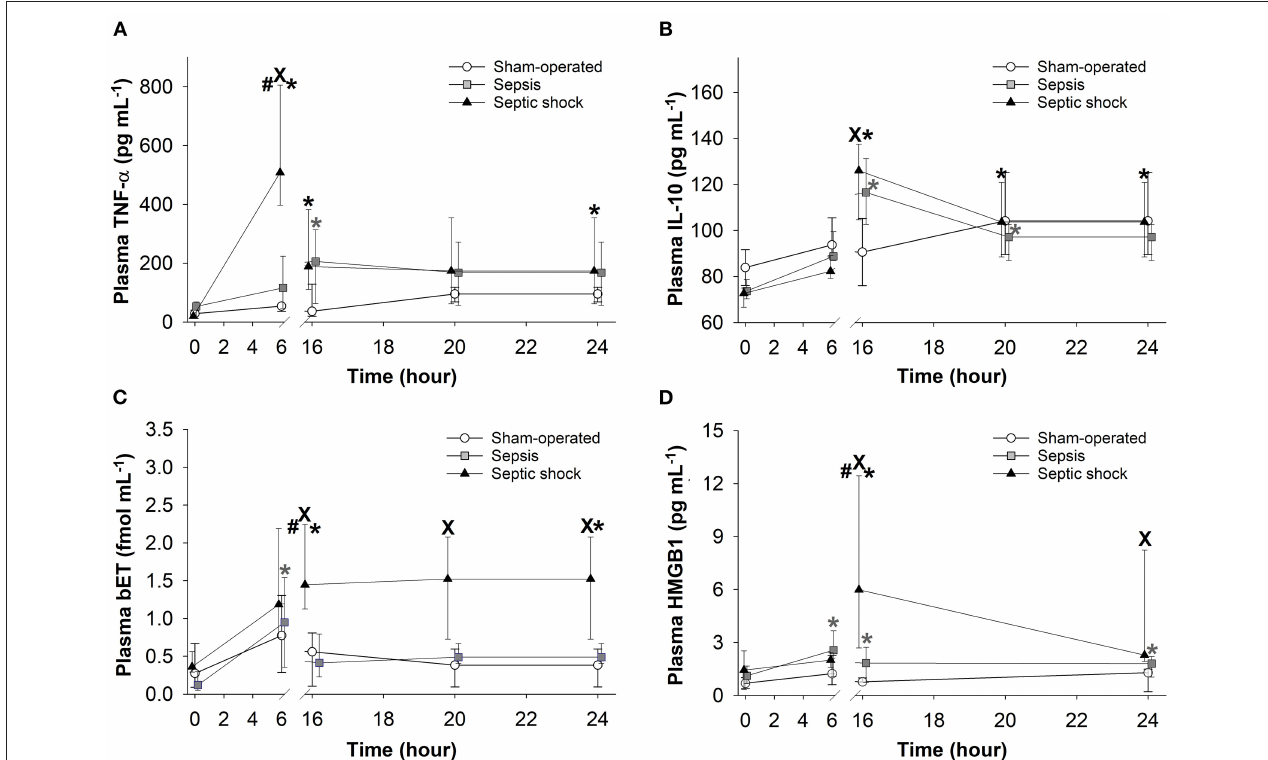
FIGURE 8 | Changes in plasma tumor necrosis factor alpha (TNF- α ) (A) , interleukin-10 (IL-10) (B) , big endothelin (bET) (C) , and high-mobility group box 1 protein (HMGB1) (D) levels in the sham-operated group (open circles) and in the sepsis (gray square) and septic shock subgroups (black triangle). The plots demonstrate the median values and the 25th (lower whisker) and 75th (upper whisker) percentiles. X P < 0.05 vs. sham-operated group; # P < 0.05 vs. sepsis group; * P < 0.05 t = 0h.